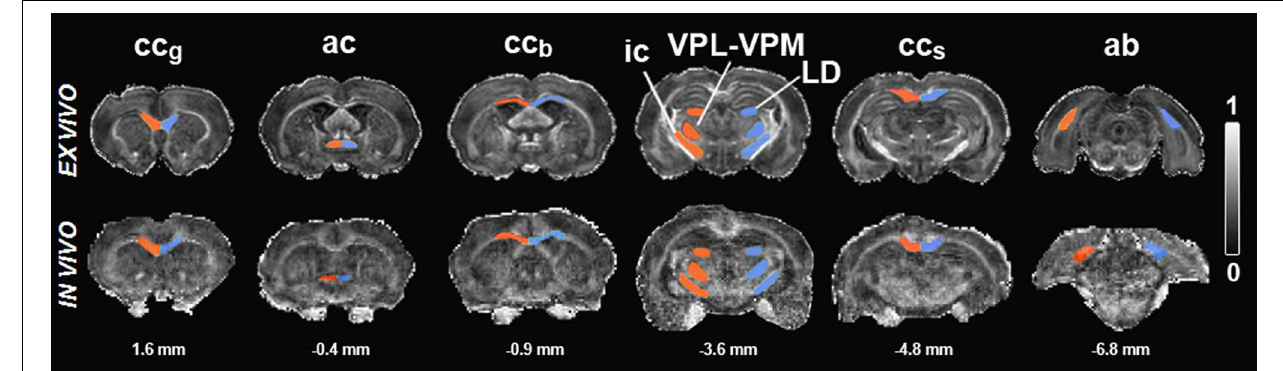
FIGURE 1 | Fractional anisotropy maps of sham-operated animals ex vivo (upper row) and in vivo (lower row). Regions of interest are outlined in red (ipsilateral) and blue (contralateral). Scale bar: 0 (black) to 1 (white). Abbreviations: ac , anterior commissure; ab , angular bundle; cc b , body of the